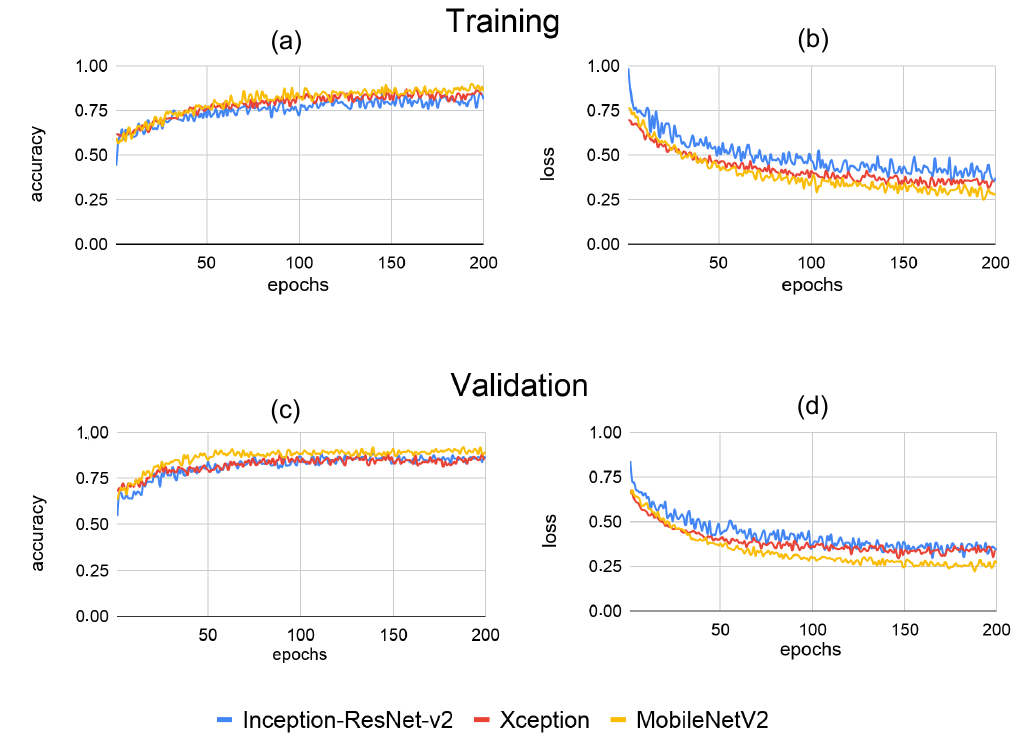
Figure 5. Performances on training ( a , b ) and validation ( c , d ) datasets during the learning process of Inception-ResNet-v2, Xception and MobileNetV2 architectures for classification of X-ray images from non-infested maize grains and grains infested with Sitophilus zeamais .